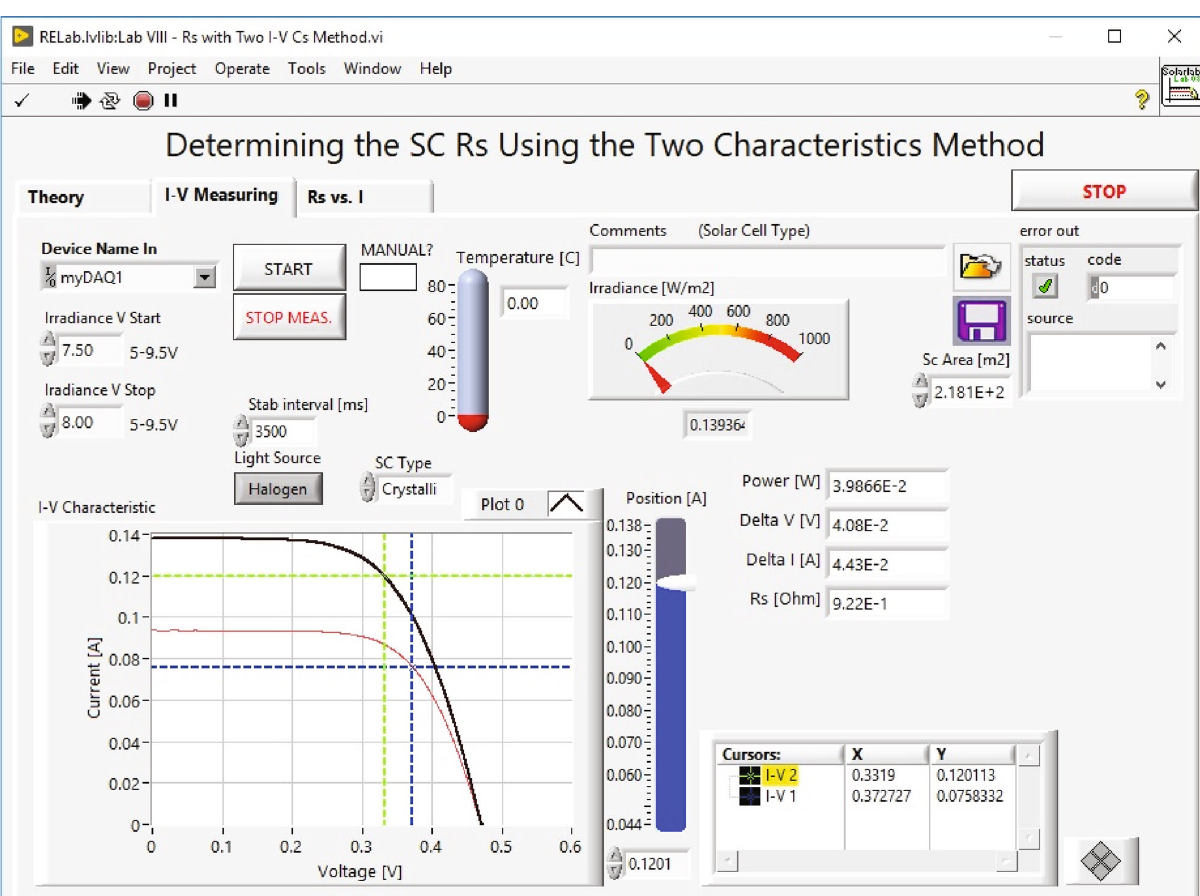
V Figure 7: I sc and oc study of the solar cell, as a function of temperature using the NI-ELVIS acquisition boards and LabView